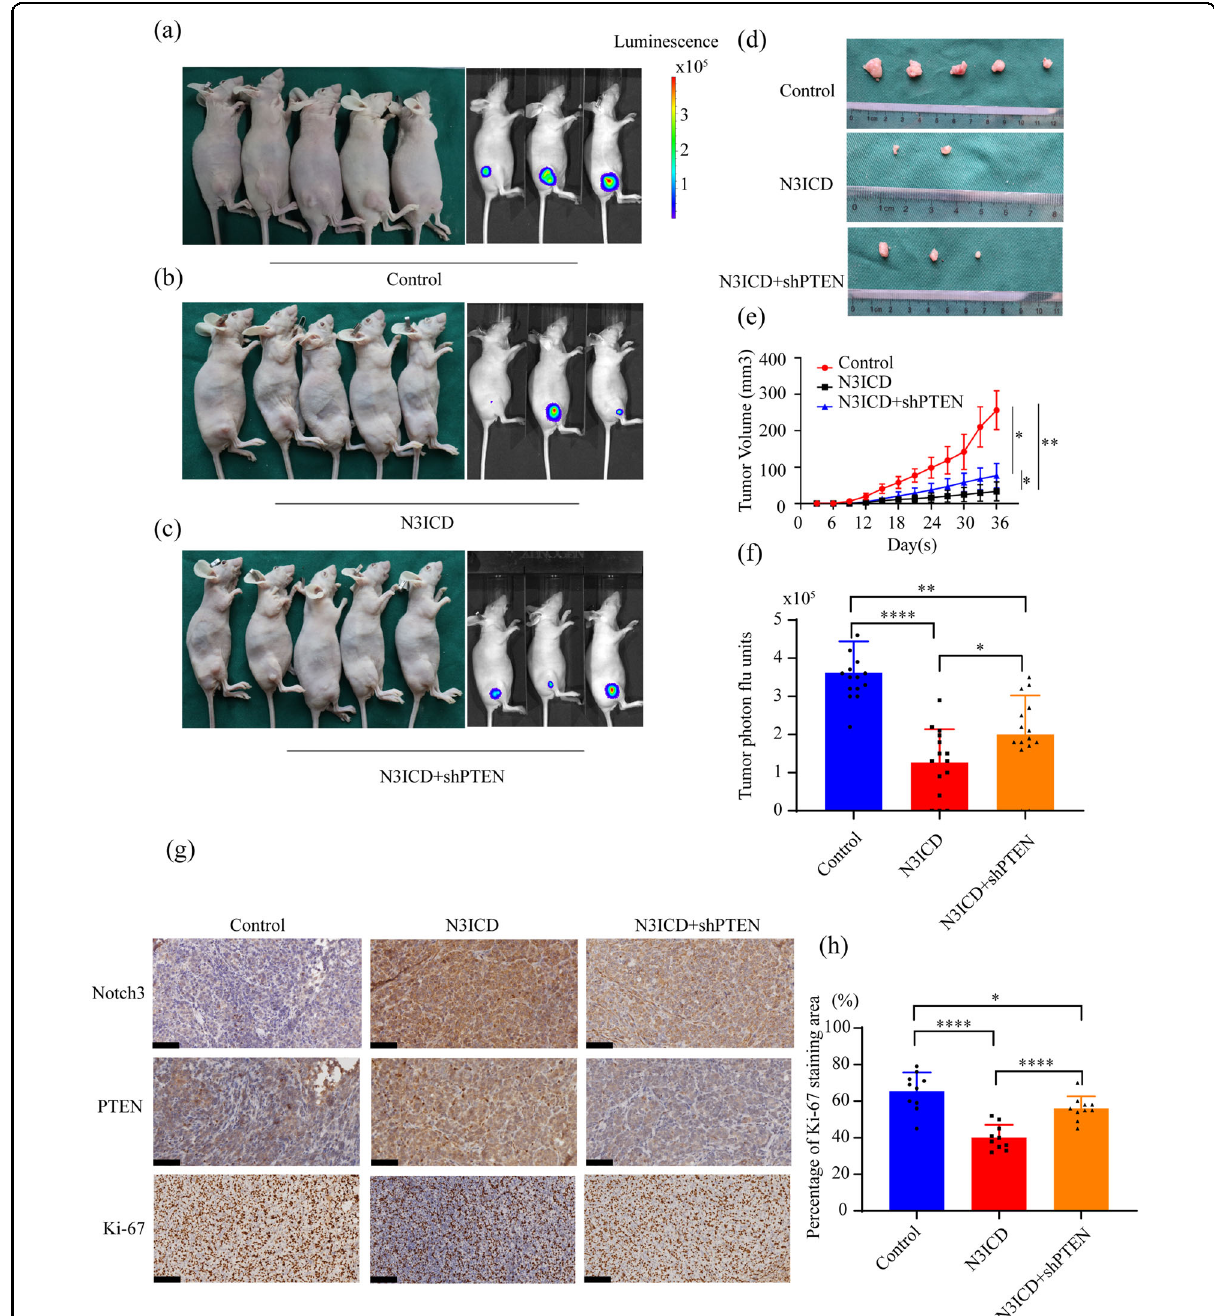
Fig. 4 Notch3 inhibits cell proliferation by regulating PTEN in vivo. a – c Control vector, Notch3-expressing, and N3ICD + shPTEN MDA-MB-231- Luc cells (2 × 10 6 cells) were injected subcutaneously into the right thigh of immunode fi cient NU/NU mice ( n = 5). Tumor size was evaluated every three days. d Primary tumors from mice inoculated with vector, N3ICD, or N3ICD + shPTEN transfected MDA-MB-231-luc cells were collected 36 days post-inoculation. e Time course of tumor growth is shown. f Quantitation of bioluminescence using the IVIS Kinetic Imaging System. g Immunohistochemical staining for Notch3, PTEN, and Ki-67 was performed on dissected tumors. h Quantitative analysis of Ki-67 staining was performed. Original magni fi cation, 200x. The scale bar indicates 50 μ m. * P < 0.05, ** P < 0.01, *** P < 0.001, **** P <